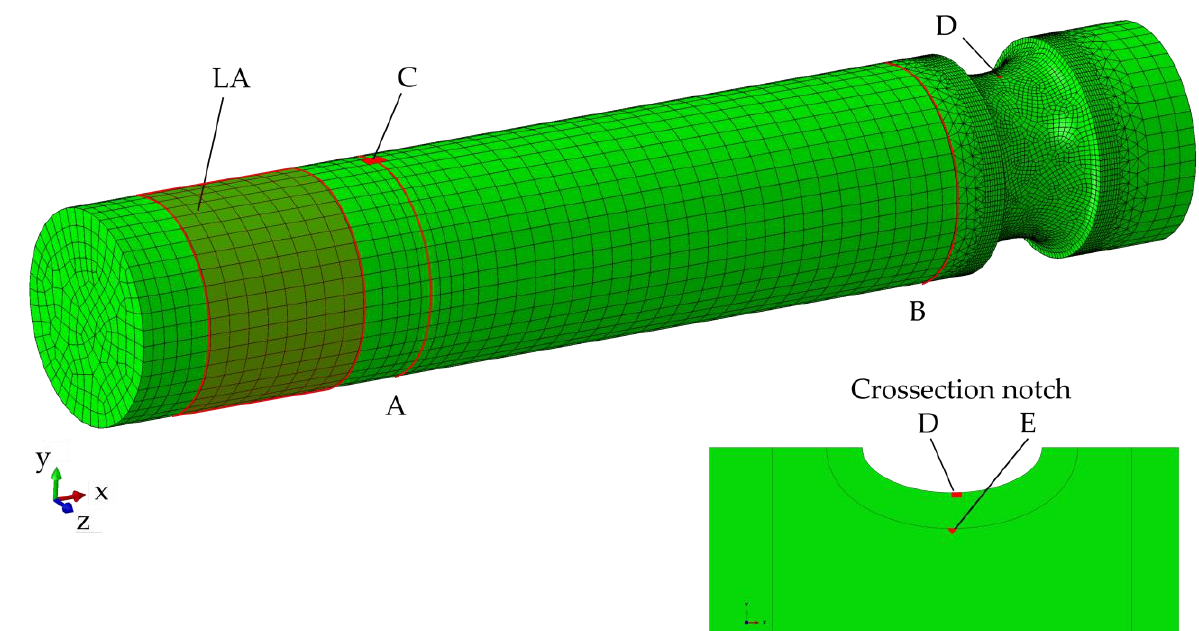
Figure 2. Finite element model with marked load application area (LA), boundary condition (A, B) and stress extraction locations (C–E).